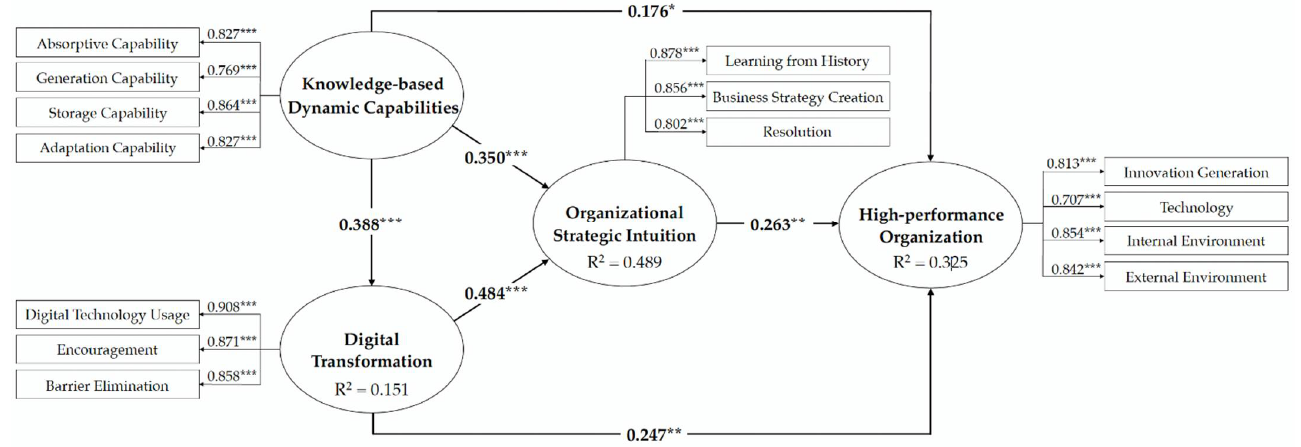
Figure 1. Results of the structural model. Note: * p < 0.05, ** p < 0.01, and *** p < 0.001, one-tailed test. Table 6. Summary